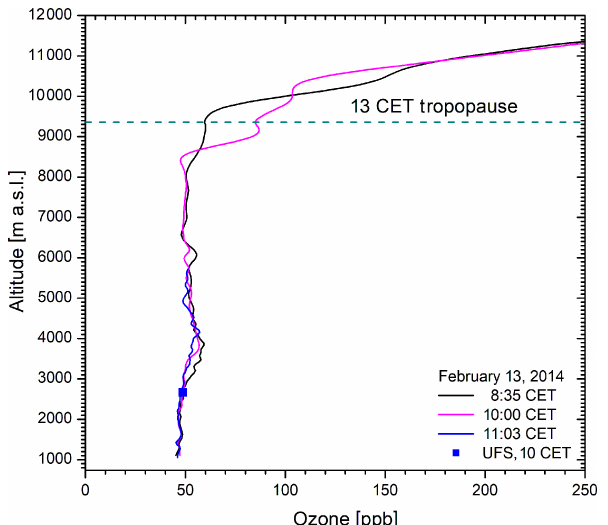
Figure 17. Ozone measurement with the stationary DIAL on 13 February 2014; the variability is low apart from the two dry layers at below 4km and at 6.1km that are also visible in the 01:00CET Munich radiosonde data and that seem to erode after 08:35CET. The agreement with the in situ measurements at UFS is perfect.